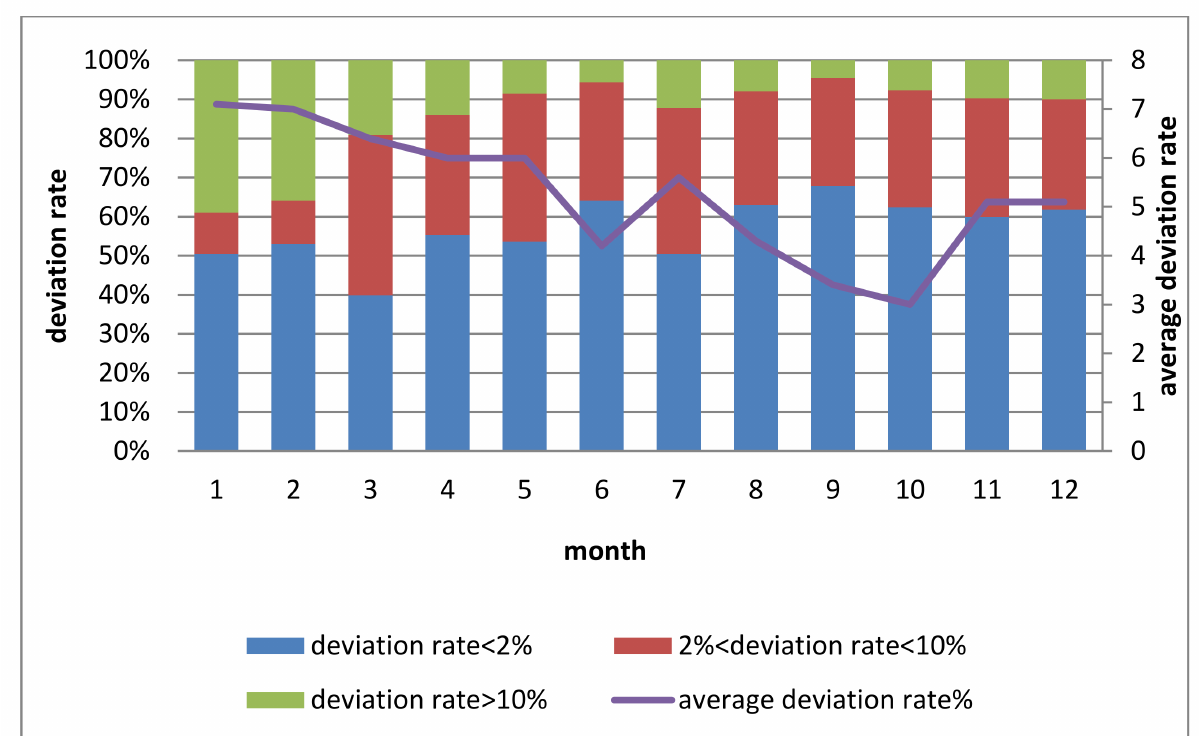
Figure 3. Electricity demand-side deviation rate of Guangdong province in 2019. Figure reference: Guangdong Electric Power Trading Center: 2019 annual report of Guangdong electric power